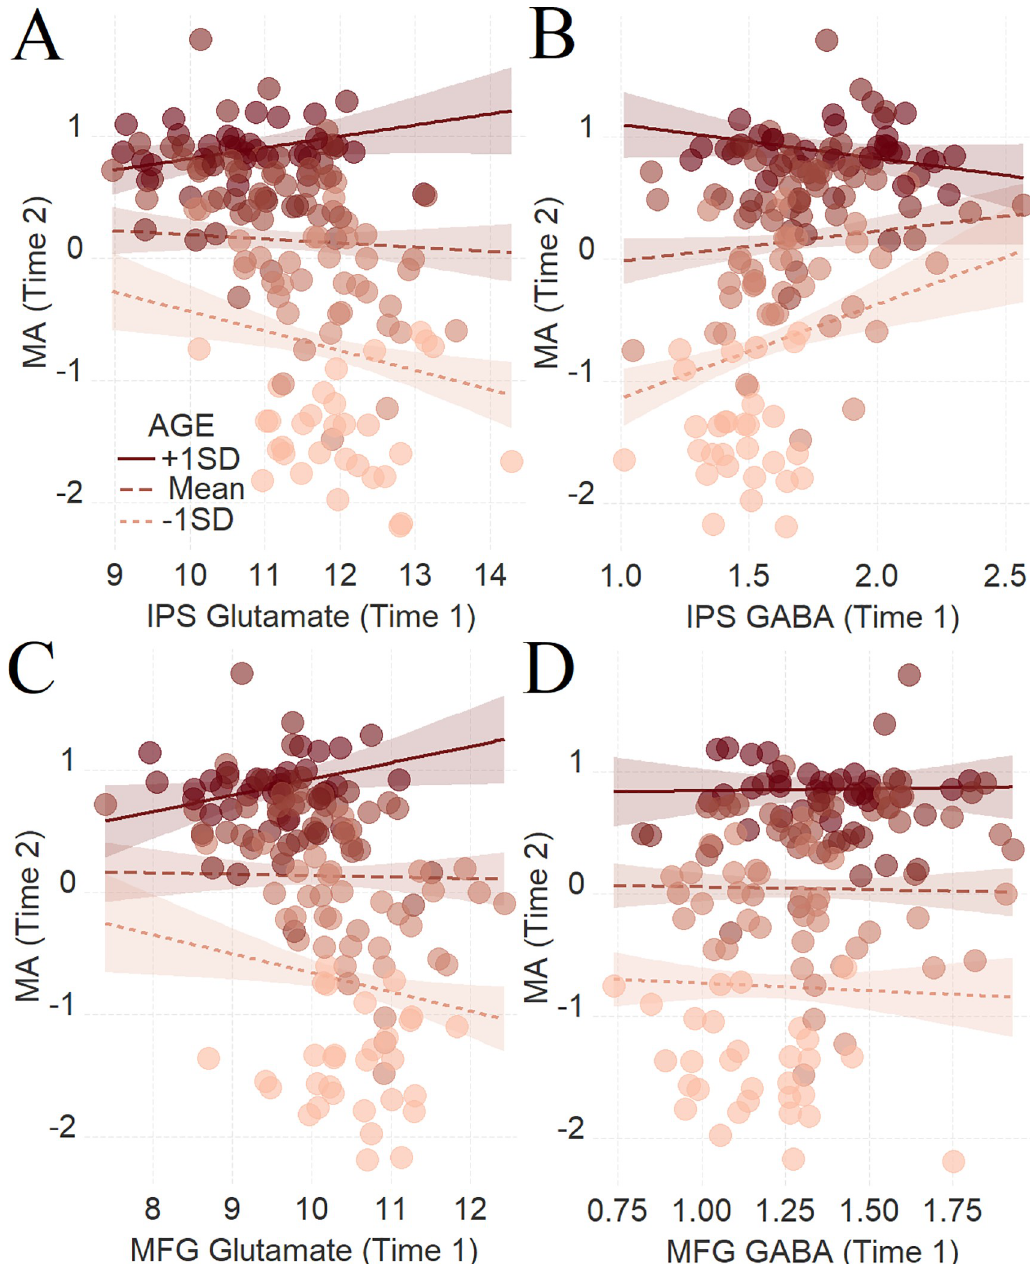
Fig 3. Predicting MA at Time 2 from the interaction between age neurotransmitter concentration at Time 1. To depict the interaction between the continuous variables, we plotted the regression lines for ± 1 SD from the mean age [53]. Dark color concerns +1 SD above the mean, while light color concerns − 1 SD below the mean. The average color represents the mean. ( A) Glutamate and (B) GABA in the left IPS; ( C) glutamate and ( D) GABA in the left MFG. The shaded area represents 95% confidence intervals. For visualization purposes, the effect of age at Time 2 was not included when generated the panels of this figure. The data underlying this figure can be found in S3 Data . GABA, gamma-aminobutyric acid; IPS, intraparietal sulcus; MA, mathematical achievement; MFG, middle frontal gyrus; SD, standard